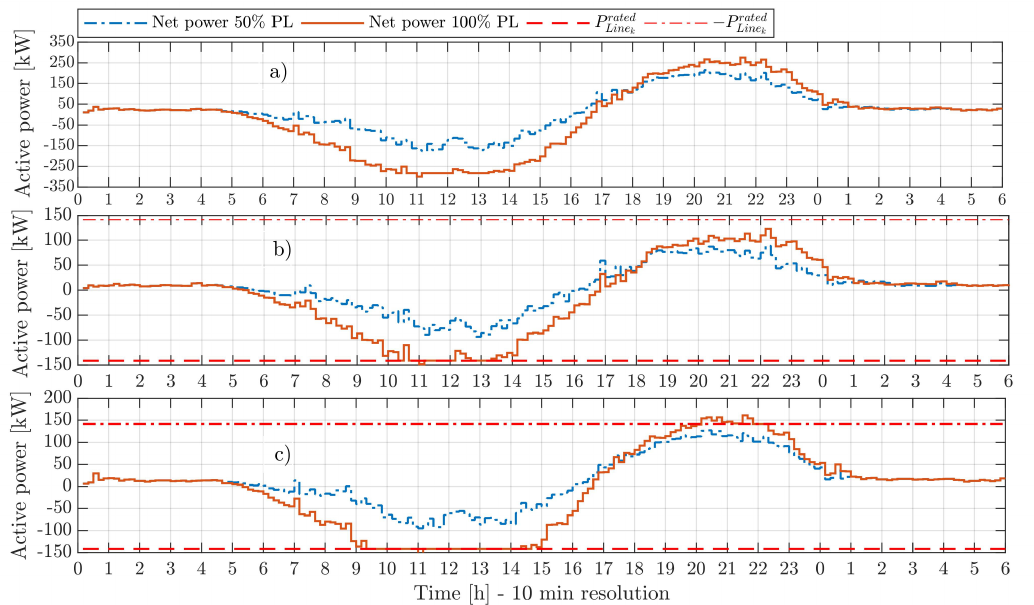
Figure 6. Net active power for a moderate and critical penetration level (PL). ( a ) On the distribution transformer, ( b ) on the feeder’s main cable of aggregator 1 and ( c ) aggregator